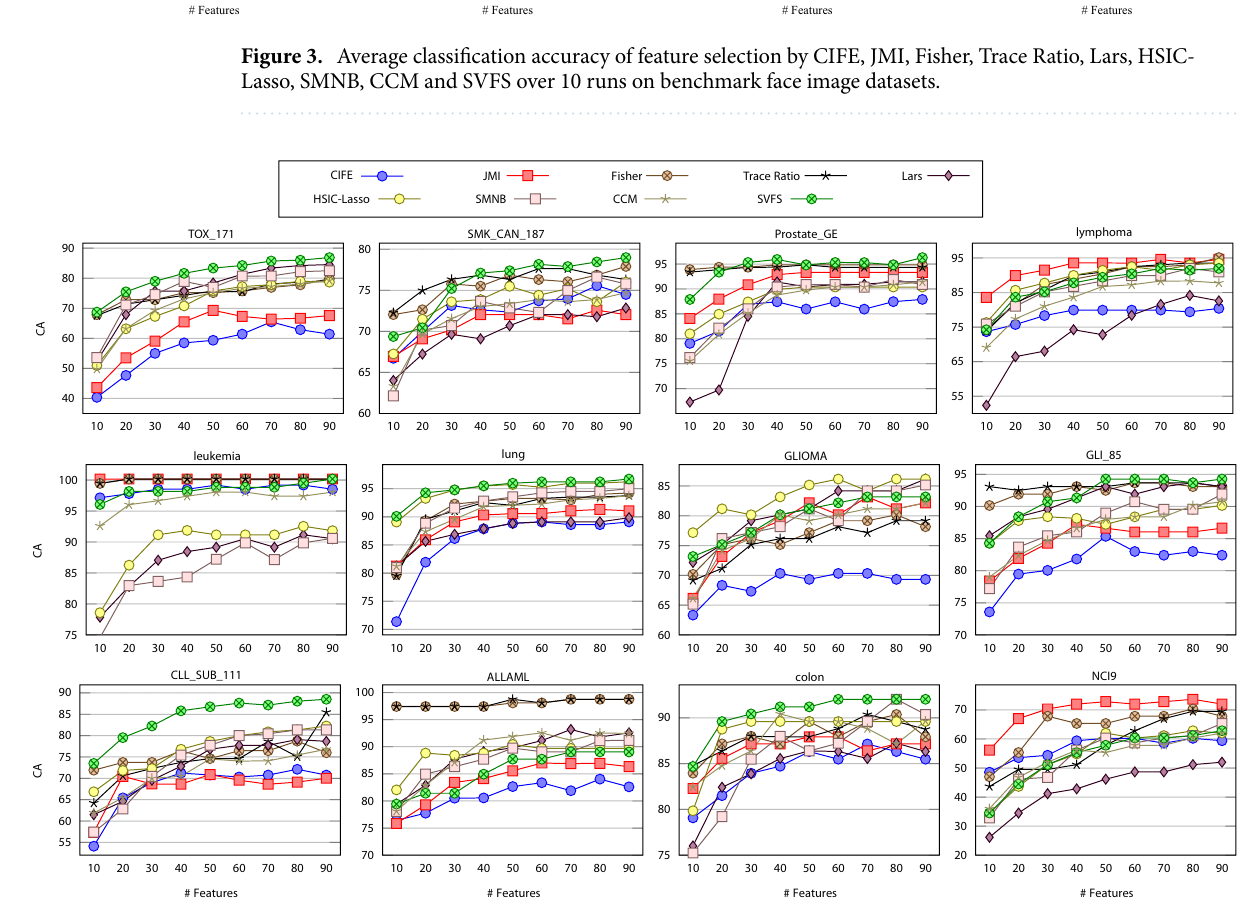
Figure 4. Average classification accuracy of feature selection by CIFE, JMI, Fisher, Trace Ratio, Lars, HSIC- Lasso, SMNB, CCM and SVFS over 10 independent runs on benchmark biological